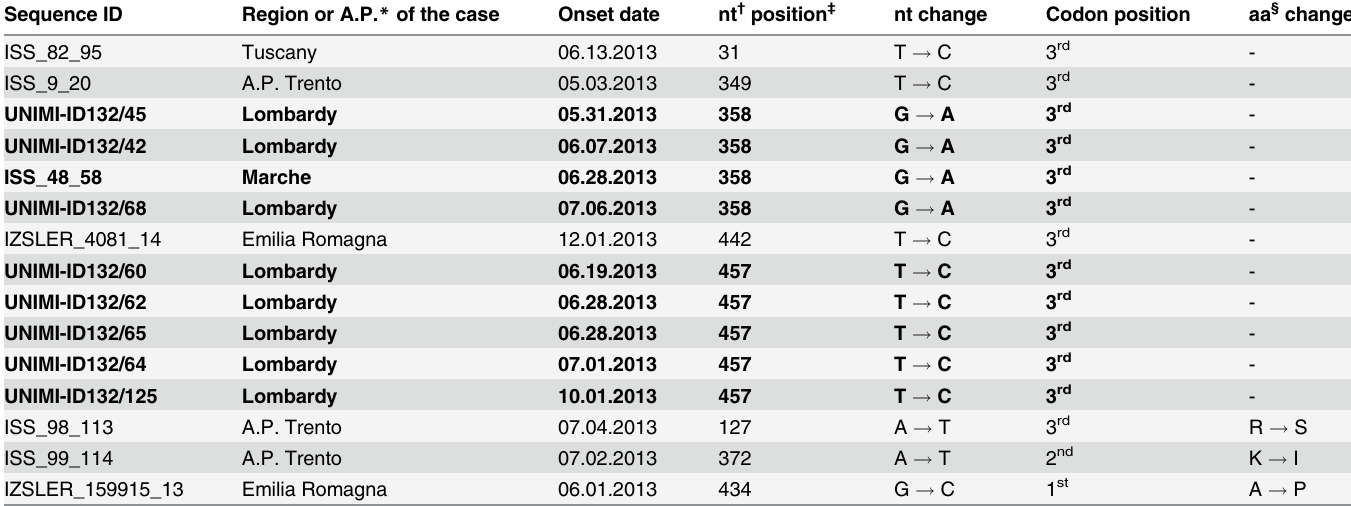
Table 1. Summary of the 15 sequences showing one only nucleotide difference vs . the reference outbreak sequence (Accession Number KF182323). Sequence ID Region or A.P. * of the case